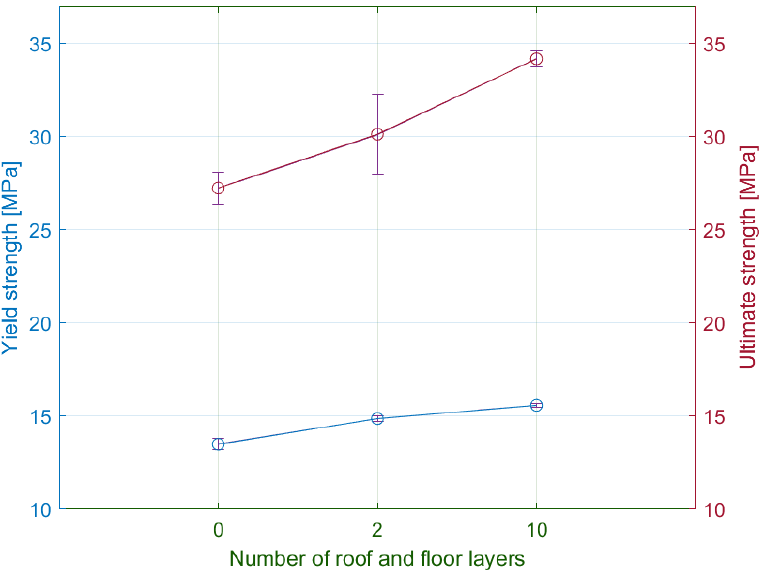
Figure 22 . Comparison of measured average values of yield strength and ultimate strength for the selected number of floor/roof layers.